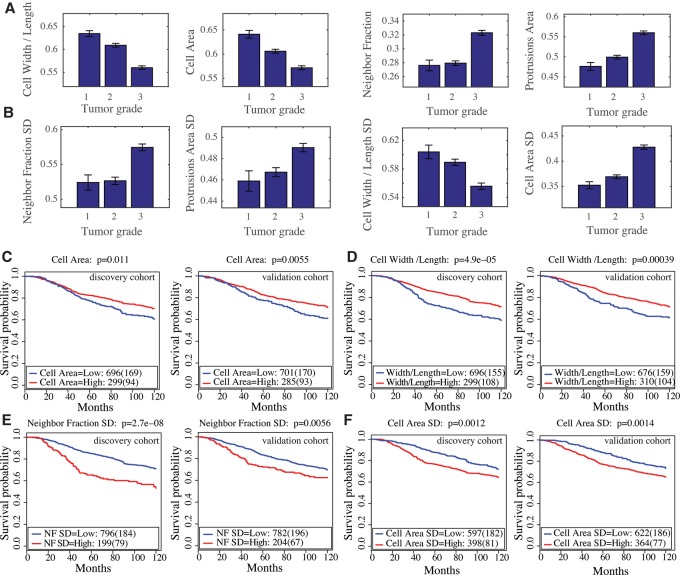
The prognostic value of the morphological metagenes and their associations with the clinical parameters in the METABRIC data set. (A) Association between tumor grade and cell W/L, cell area, NF, and protrusion area metagenes. All these associations are significant, with P-value < 0.0005 using the Jonckheere–Terpstra test. Error bars indicate the standard error of the mean (SEM). (B) Association between tumor grade and NF SD, protrusion area SD, cell W/L SD, and cell area SD metagenes. These associations are significant, with P-value < 0.0005 using the Jonckheere–Terpstra test. Error bars indicate the SEM. (C–F) Kaplan–Meier curves to illustrate the disease-specific survival probabilities of patient groups in discovery and validation cohorts in the METABRIC data set stratified by (C) cell area, (D) cell W/L, (E) NF SD, and (F) cell area SD metagenes.